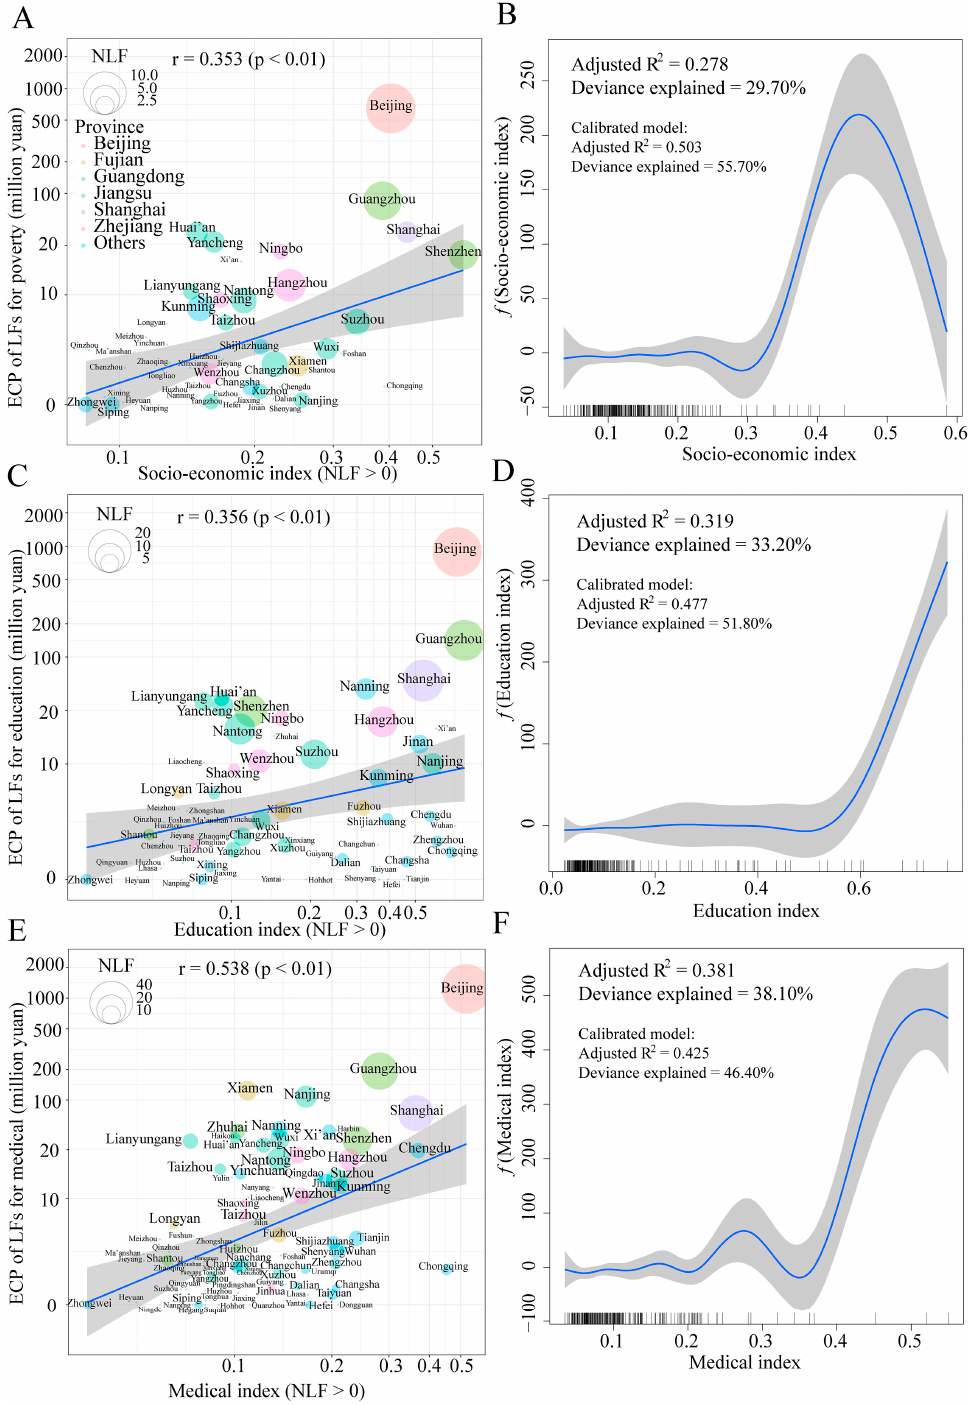
Figure 7. Linear ( A, C and E ) and nonlinear ( B, D and F ) relationships between the charity expenditures of local foundations and local population conditions.